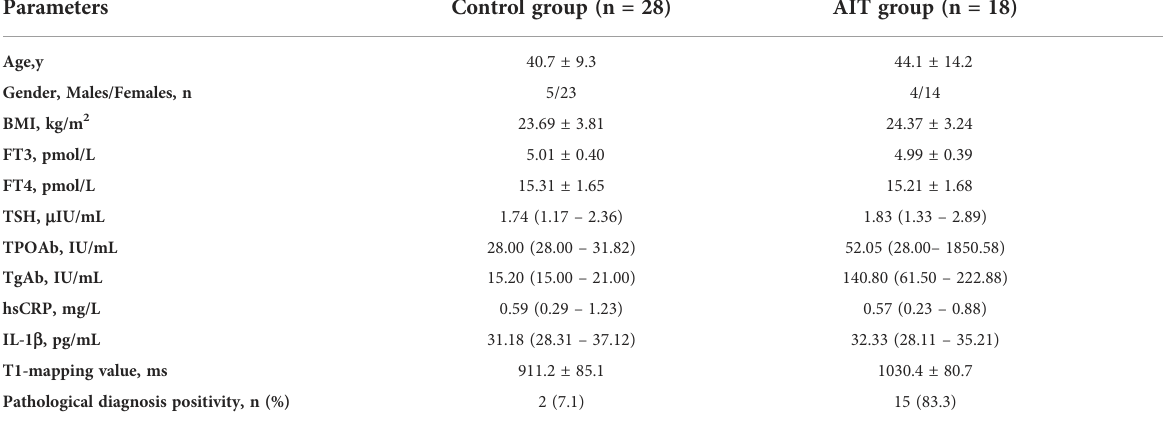
TABLE 1 The baseline characteristics of the control and AIT groups.